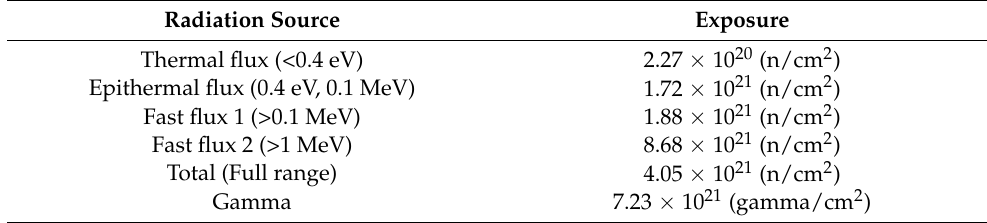
Table 4. Total fluence for irradiation in MITR [14].